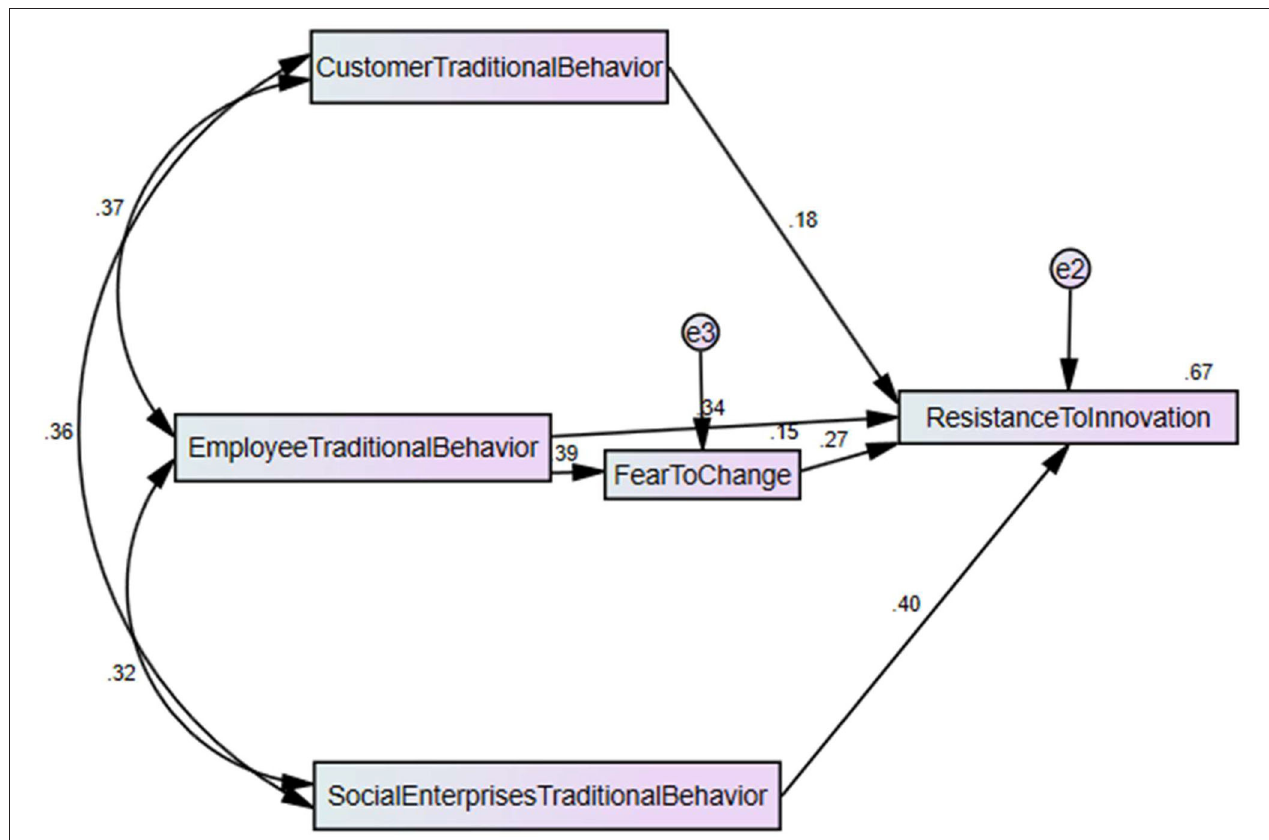
FIGURE 2 | Structural model